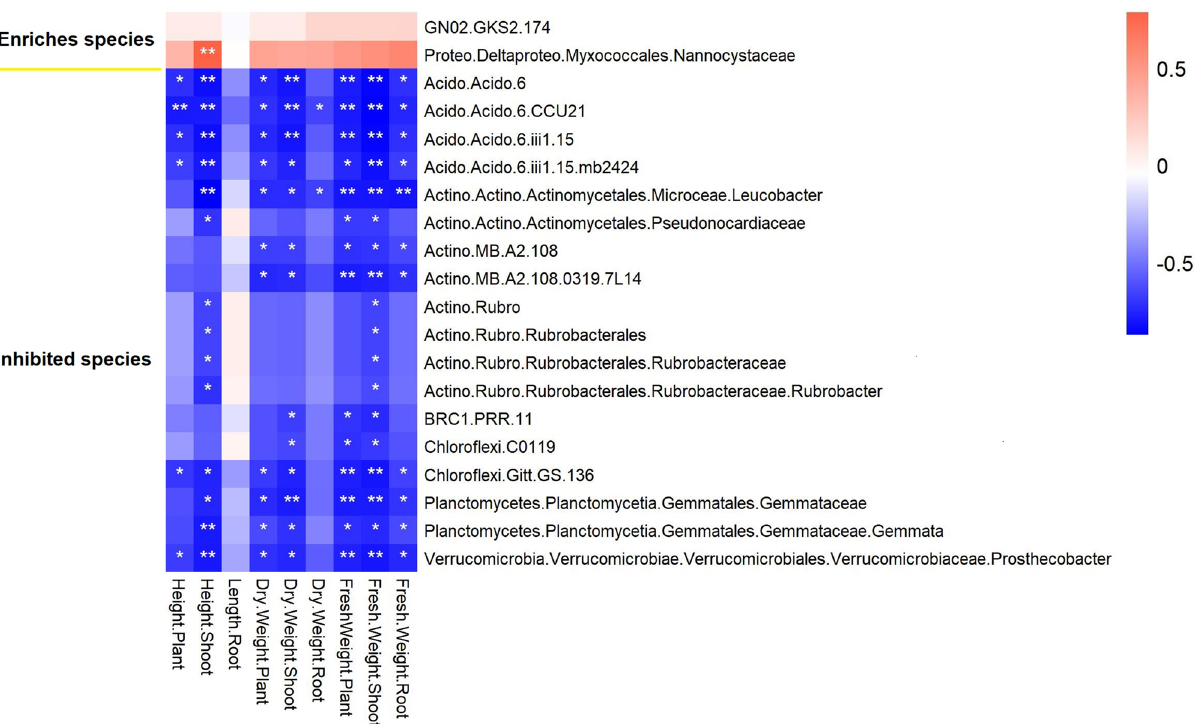
Figure 5. Heatmap of Spearman’s correlation coefficients between cucumber seedlings and bacteria inhibited and enriched by FH. The colors represent the correlation, with red being more positive and blue being